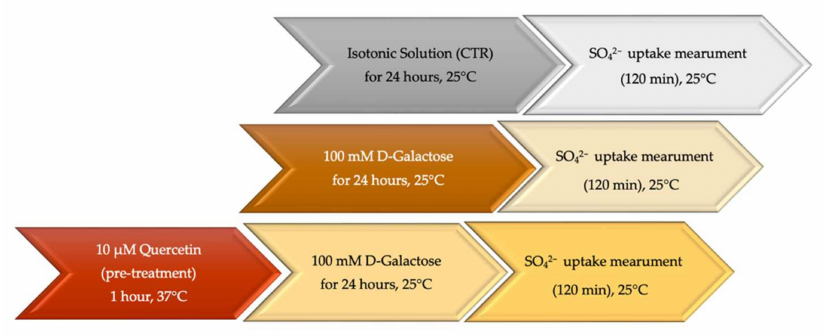
Figure 8. Time course of experimental procedures before SO 42 − uptake